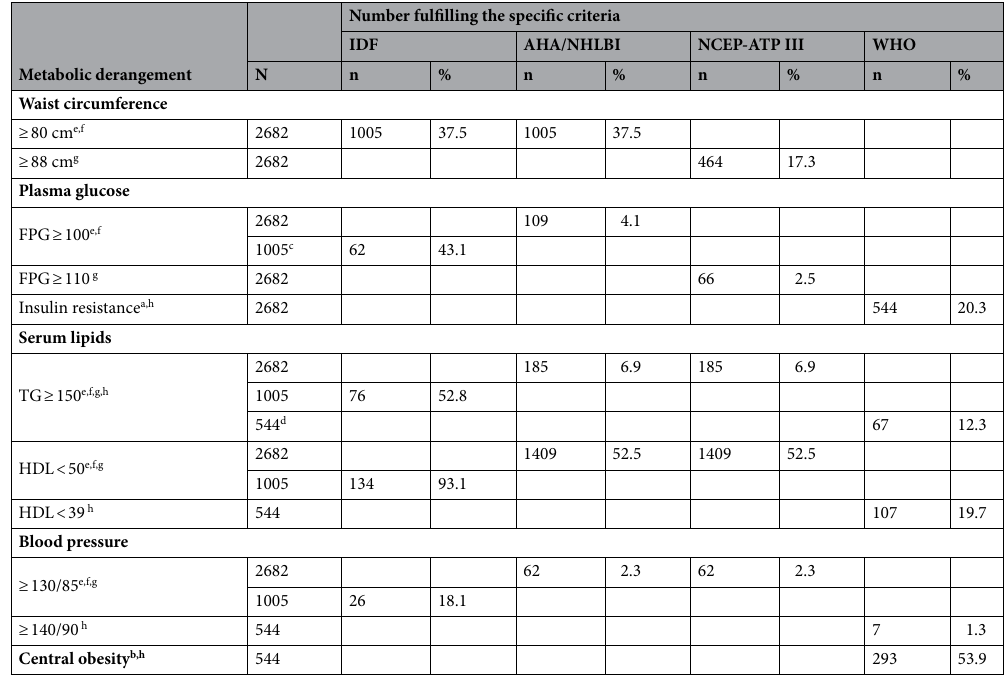
Table 4. Prevalence of metabolic derangements (parameters) among a population-based cohort of 2682 pregnant women with period of gestation < 12 weeks from Anuradhapura, Sri Lanka. a Insulin resistance- identified by any one of these: a) Type 2 diabetes mellitus b) Impaired fasting glucose c) Impaired glucose tolerance. b BMI > = 30 and/or WHR > 0.85. FPG fasting plasma glucose, TG triglycerides, HDL high density lipoproteins, BMI body mass index, WHR waist hip ratio. N-Shows the total number of samples considered for each metabolic derangement. c 1005 is the number of women with ≥ 80 cm waist circumference. d 544 is the number of women with insulin resistance under WHO criteria. e IDF International Diabetes Federation. f AHA/NHLBI American Heart Association/National Heart, Lung and Blood Institute. g NCEP ATP III National Cholesterol Education Programme Adult Treatment Panel III. h WHO World Health